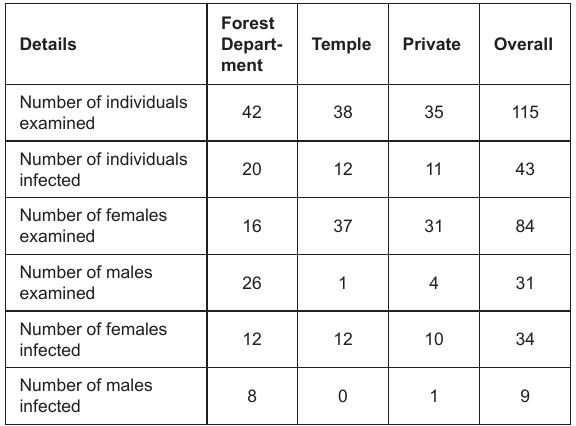
Table 1. Number of elephants examined for prevalence of intestinal parasites and the details of individuals infected in different systems and